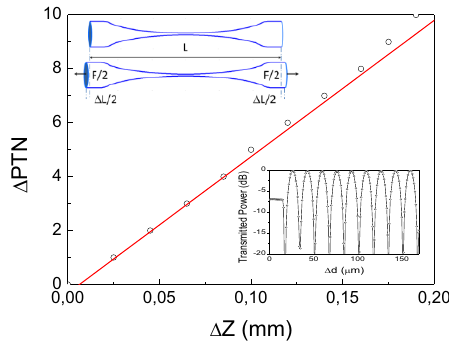
Fig.4. Experimental (cid:3) PTN as a function (cid:3) Z (open circles). Red line represents the analytic model for the digital response of the sensor for the strain range (cid:3) L/L o . Inset shows 20 PTTP of the transmitted power as a function of taper elongation. A negligible hysteresis value of - 0.4 μm was